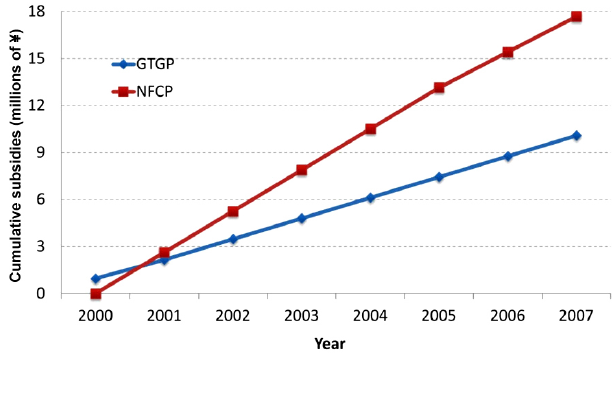
Fig. 5 . Cumulative amounts of subsidies to Wolong from the Chinese central government through the Natural Forest Conservation Program (NFCP) and Grain-to-Green Program (GTGP). Data were obtained from government records on investment in the Natural Forest Conservation Program and the Grain-to-Green Program (Wolong Nature Reserve 2005, 2010). The Natural Forest Conservation Program and the Grain-to-Green Program payment rates are flat (i.e., the present values in each corresponding year are not